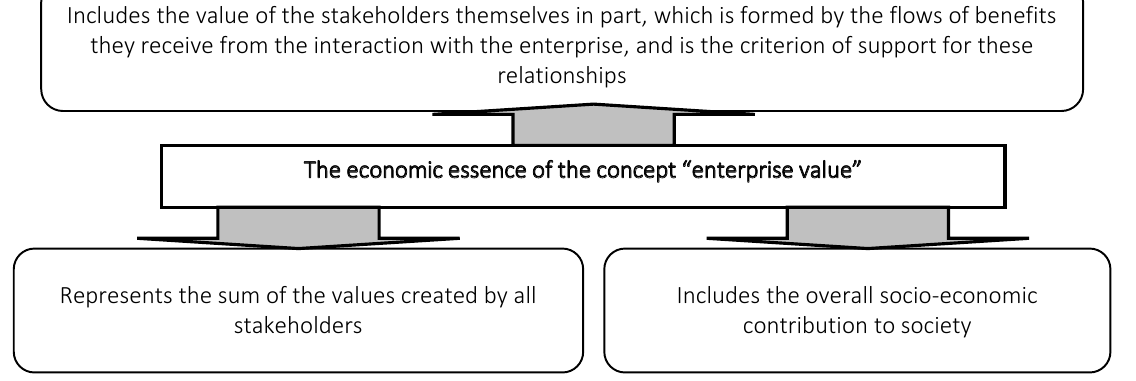
Figure 4. The economic essence of the category “enterprise value” in the framework of the stakeholder